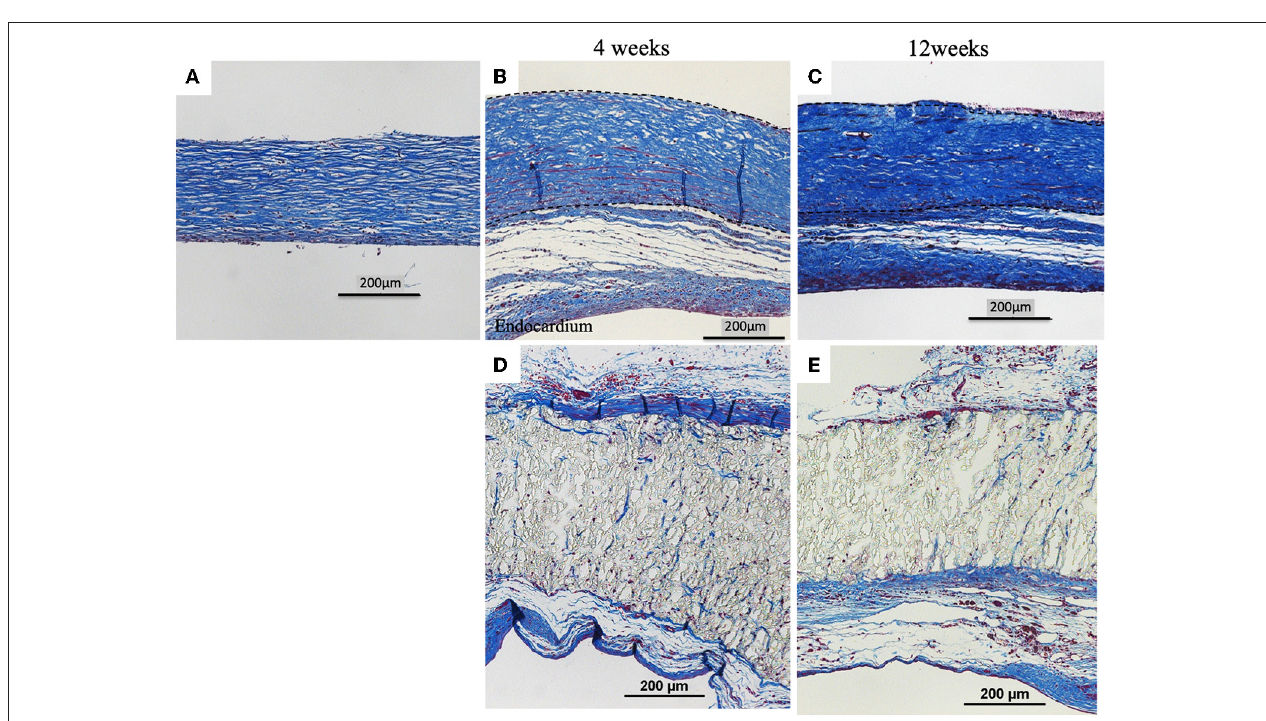
FIGURE 5 | Results of histological examination (Masson’s Trichrome Stain). (A) Image before implantation of biosheet. Images at 4 and 12 weeks after implantation of biosheets (B,C) and ePTFE (D,E) patches. Biosheets had higher collagen density at explantation than at pre-implantation.